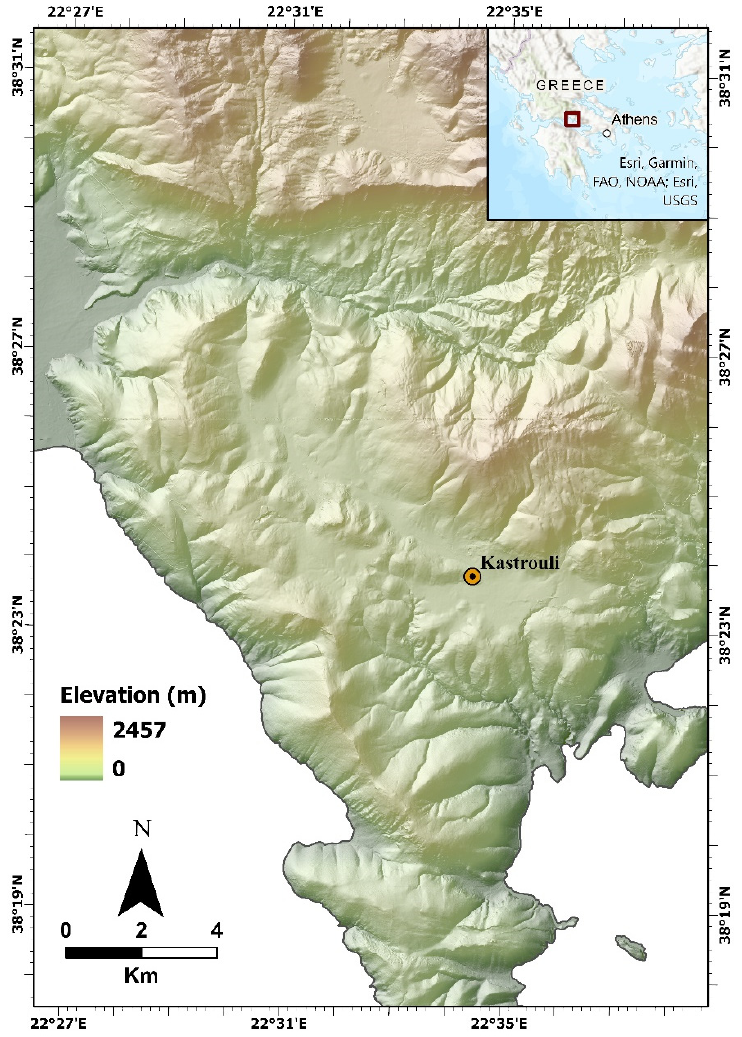
Figure 8. Digital elevation model of Southern Phocis area with Kastrouli fortified settlement.